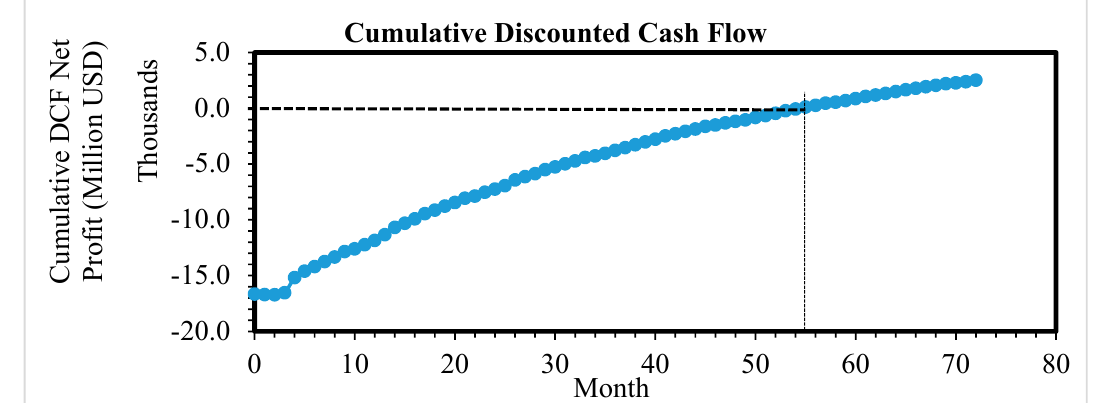
Figure 6. Cumulative cash flow (CCF) and cumulative discounted cash flow (CDCF) at an interest rate of 2%.